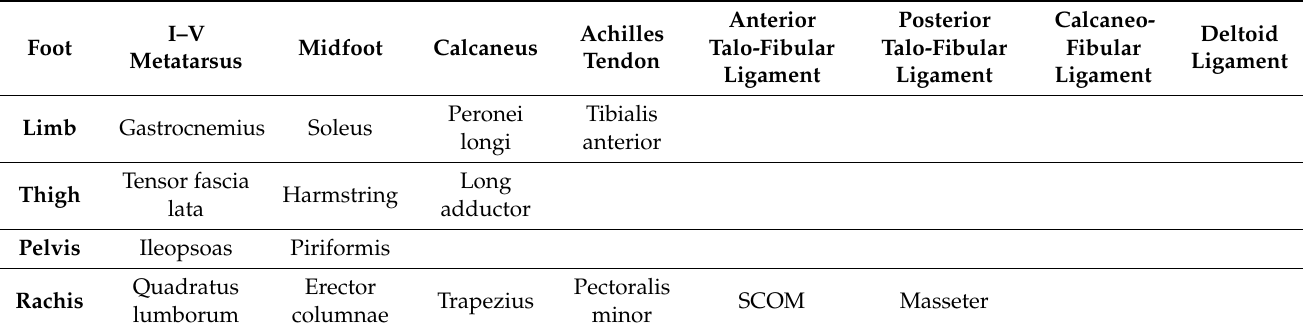
Posterior Talo-Fibular Ligament